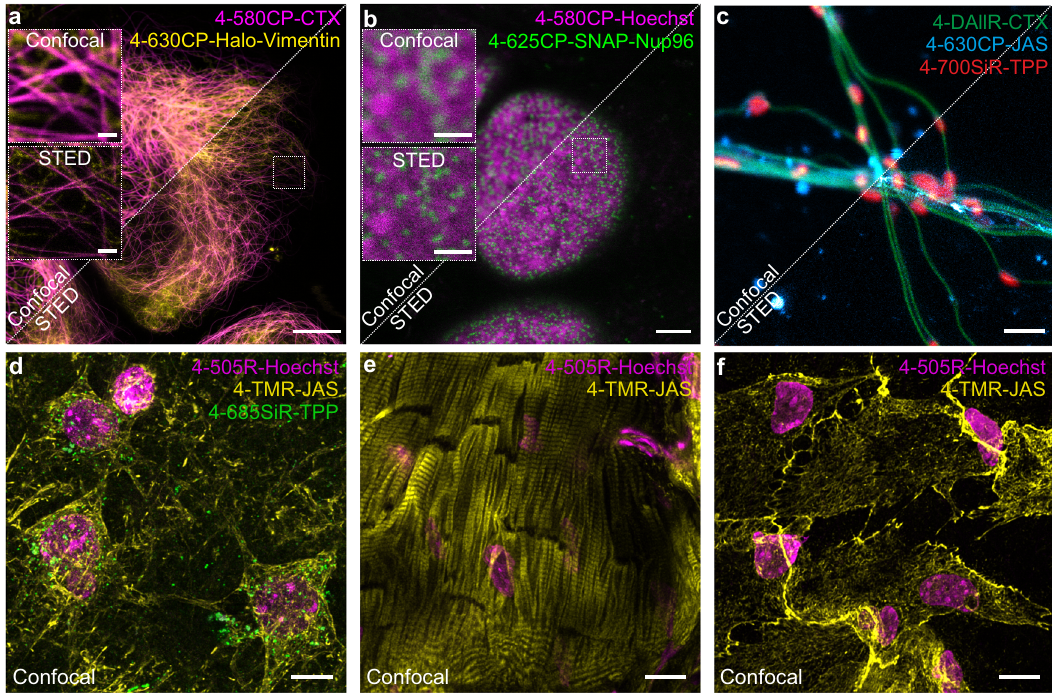
Fig. 6 | Confocal and STED images of living cells and tissues stained with cell membrane-permeable probes. a Confocal and STED images of U-2 OS cells expressing vimentin-Halo stained with 100nM 4-630CP-(O 4 )Halo ( 70 ) and 100nM 4-580CP-CTX ( 54 ). Images acquired on an Abberior Expert Line microscope. Scale bars: large — 10 µ m, insets — 1 µ m. b Confocal and STED images of U-2 OS cells expressing Nup96-SNAP stained with 100nM 4-625CP-BG ( 107 ) and 100nM 4- 580CP-Hoechst. Images acquired on an Abberior Expert Line microscope. Scale bars:large — 3 µ m,insets — 1 µ m. c ConfocalandSTEDimagesofisolatedmouseliving neuronsstainedwith10nM4-DAllR-CTX( 52 ),10nM4-630CP-JAS( 103 ),and10nM